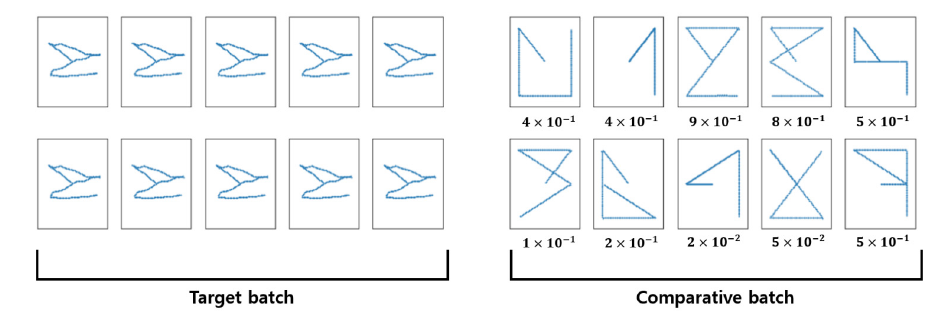
Figure 10. Data batches for test.